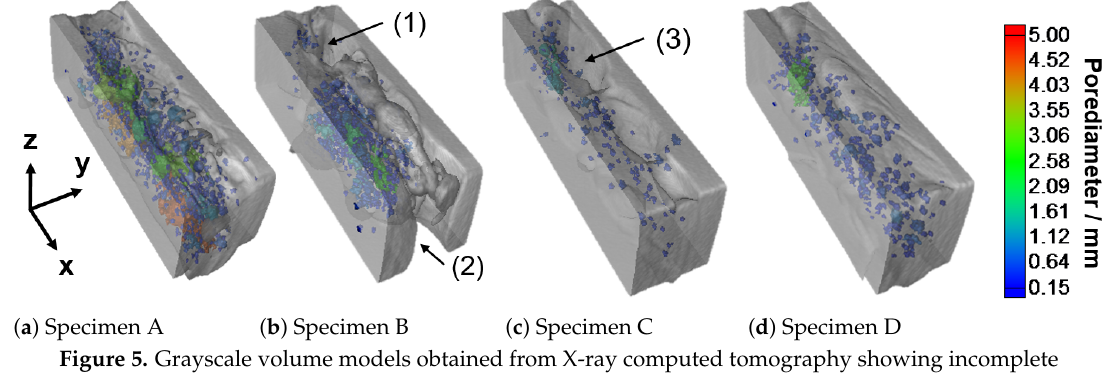
Figure 5. Grayscale volume models obtained from X-ray computed tomography showing incomplete fusion (1,2) and irregular weld surfaces (3). The pore diameter is depicted in pseudo colour.